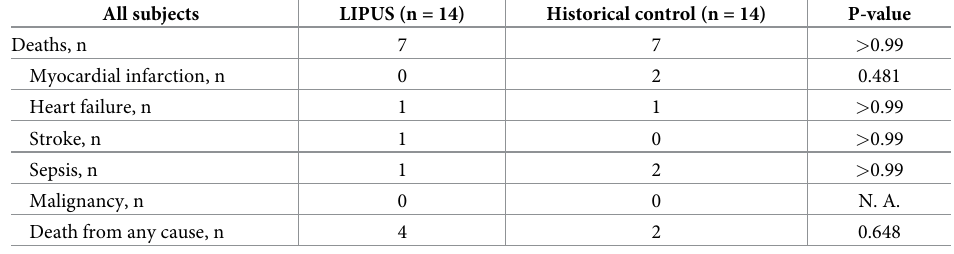
Table 2. Causes of death in patients with CLI who were treated with LIPUS and historical controls up to 5 years of follow-up. All subjects LIPUS (n = 14) Historical control (n = 14) P-value Deaths, n 7 7 > 0.99 Myocardial infarction, n 0 2 0.481 Heart failure, n 1 1 > 0.99 Stroke, n 1 0 > 0.99 Sepsis, n 1 2 > 0.99 Malignancy, n 0 0 N. A. Death from any cause, n 4 2 0.648 CLI indicates critical limb ischemia; LIPUS, low-intensity pulsed